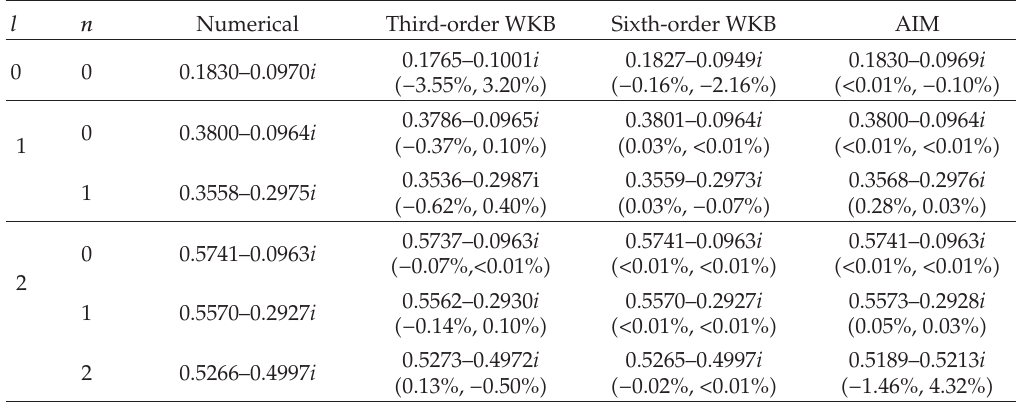
Table 9: The QNM frequencies for the spin half perturbations of the Kerr black hole, with a (cid:8) 0 . 00, that is, the Schwarzschild limit (cid:2) M (cid:8) 1 ,m (cid:8) 0 (cid:3) . Numerical data via the CFM were taken from (cid:5) 48 (cid:6) , where the AIM was set to run at 15 iterations.